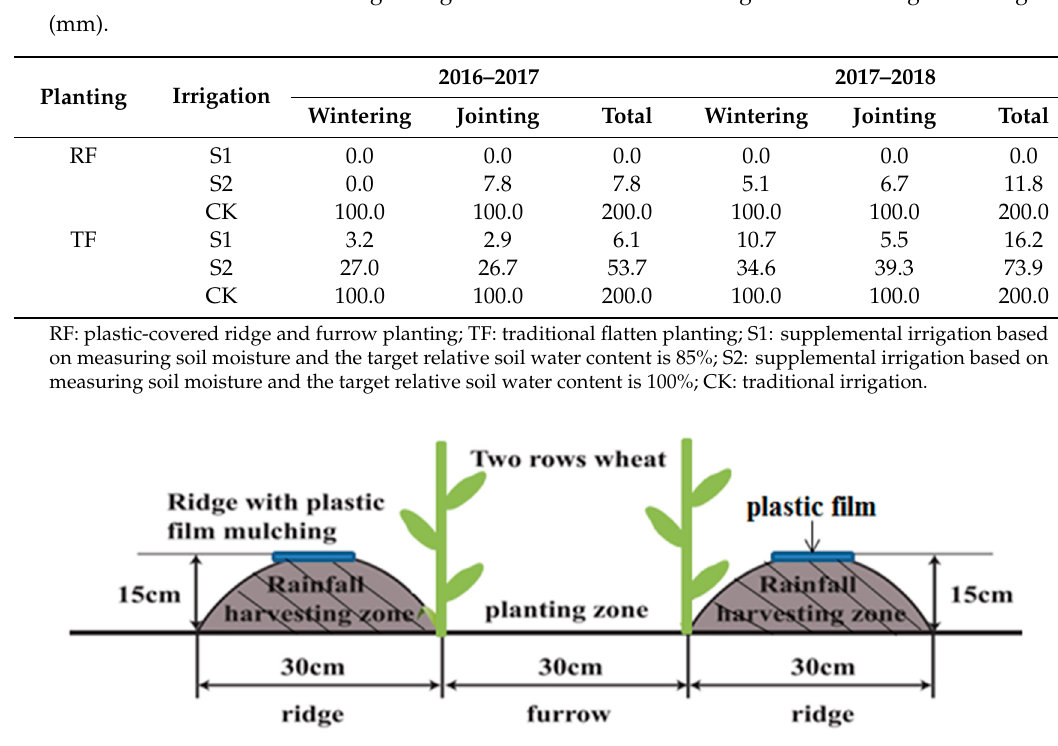
Figure 2. Schematic diagram for the plastic-covered ridge and furrow planting system (RF).